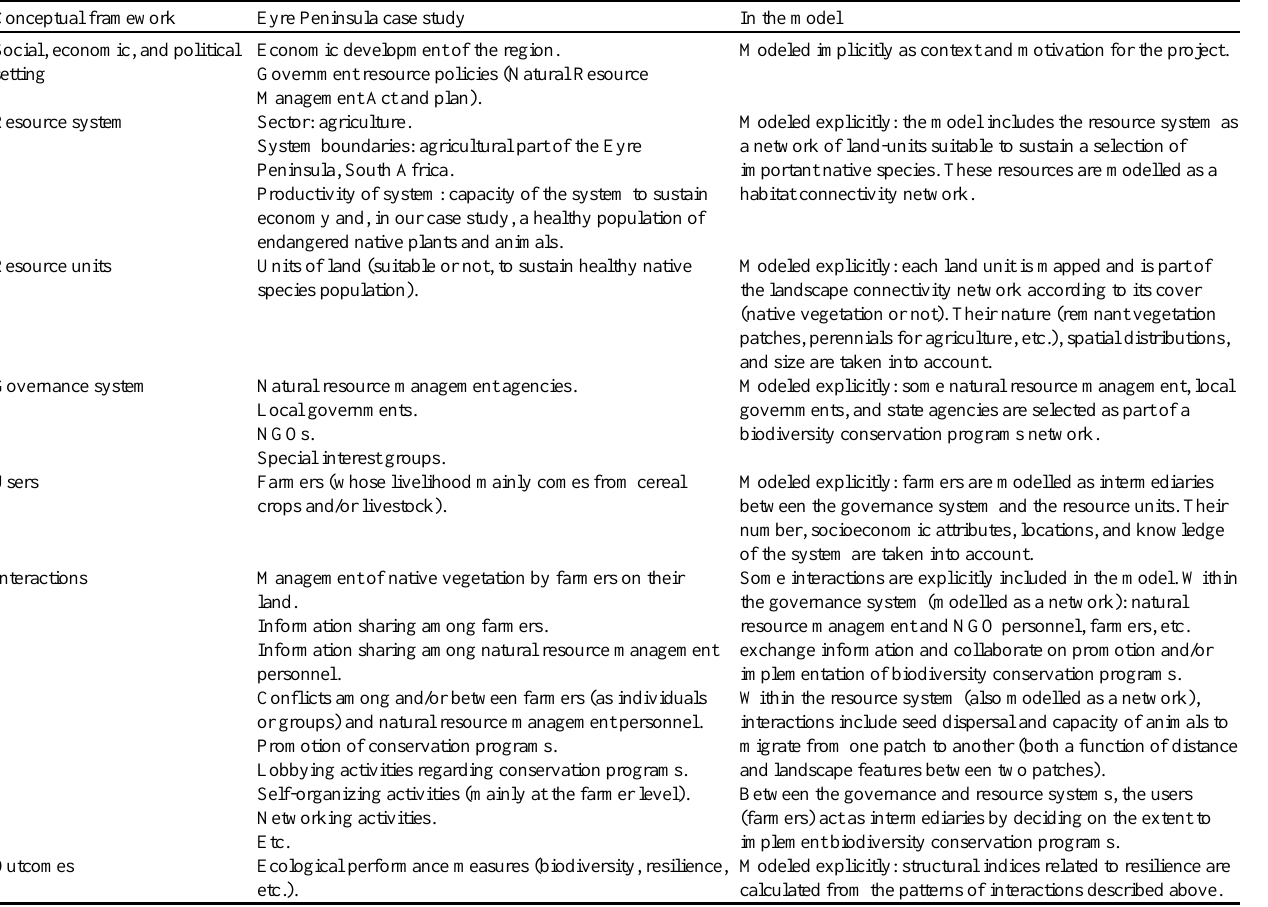
Table 3 . Conceptual framework of case study 3: Eyre Peninsula, South